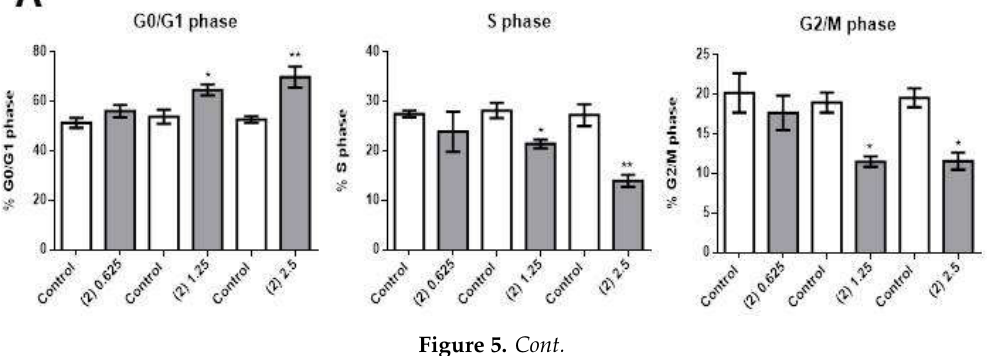
Figure 5. Figure 5. Cont.